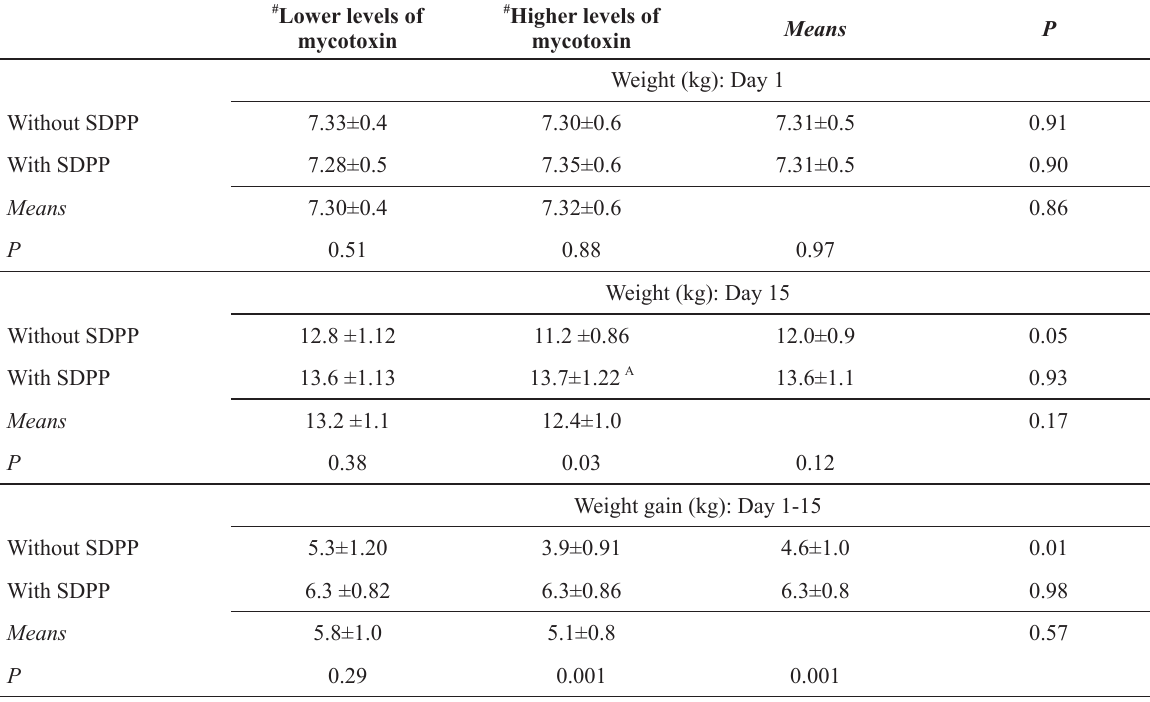
Weight and weight gain of piglets of fed with mycotoxin diet and supplemented with spray-dried porcine plasma